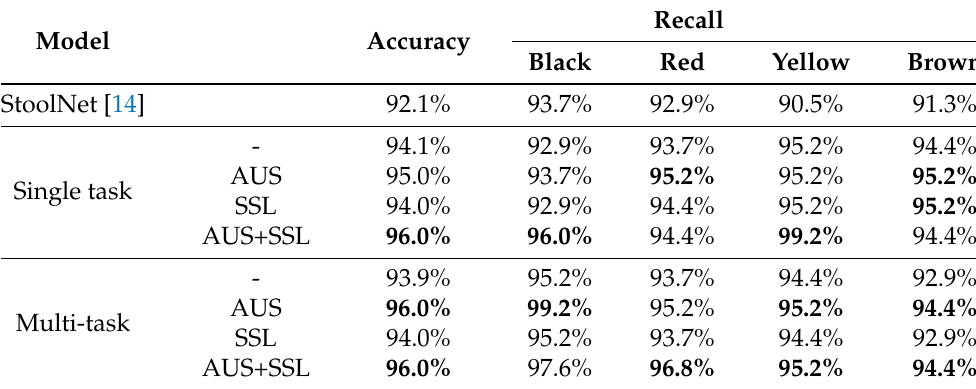
Table 6. Results for four color categories in real